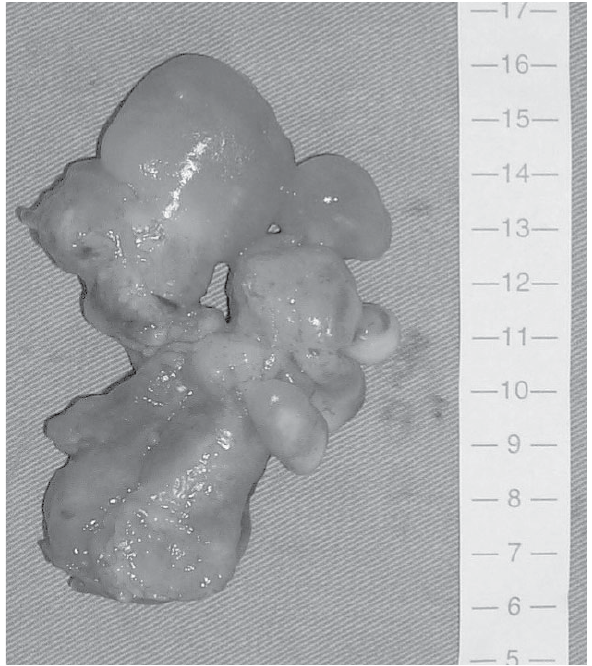
Fig. 2 - The gelatinous surgical aspect of the tumor excised was very similar to the atrial myxoma